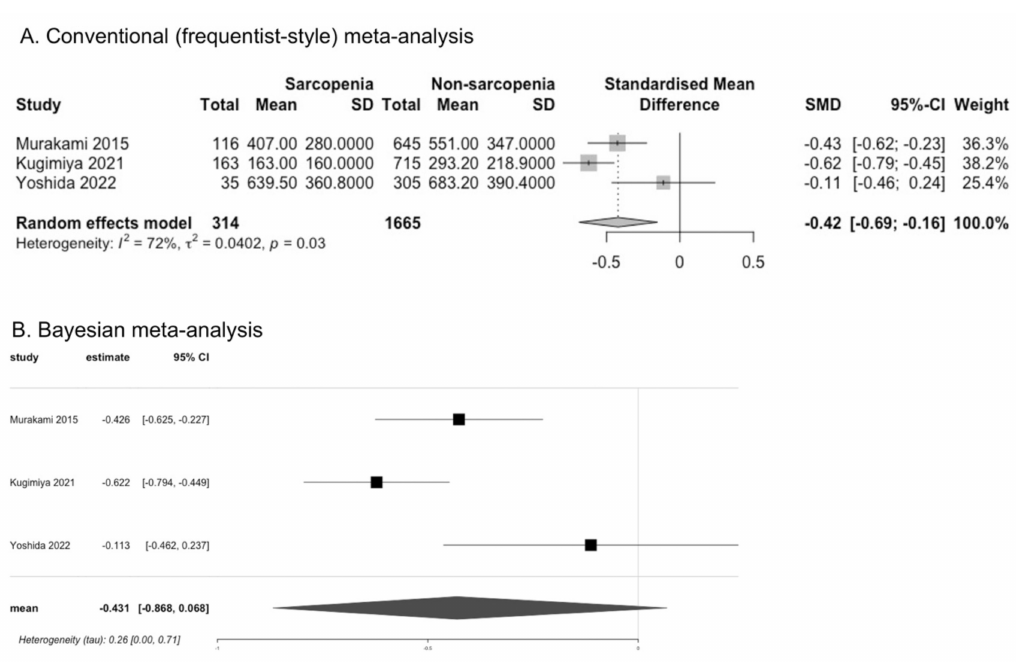
Figure 3. Comparison of occlusal force between individuals with and without sarcopenia